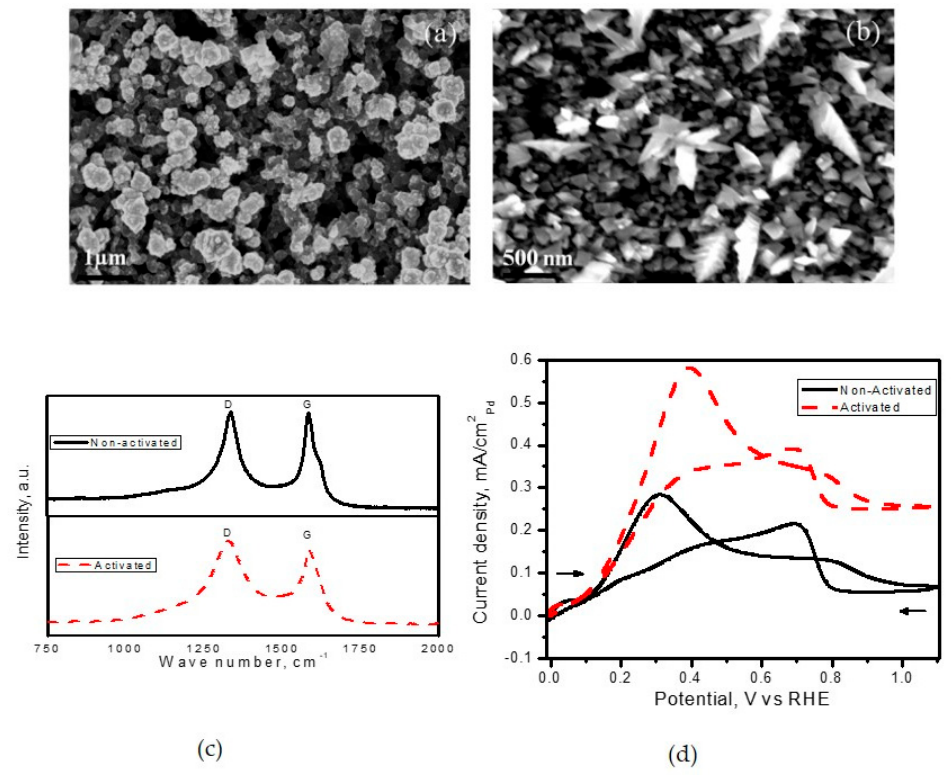
Figure 6. Scanning electron micrographs of Pd on ( a ) non-activated carbon support and ( b ) elec- trochemically activated carbon support. ( c ) Raman spectra of non-activated and electrochemically activated Vulcan coated on graphite electrode. Loading of Vulcan on graphite substrate: 100 µ g cm − 2 . Number of electrochemical activation cycles: 100. ( d ) Cyclic voltammograms comparing the specific activity of Pd catalyst on non-activated carbon and electrochemically activated carbon in nitrogen sat- urated 0.5 M H 2 SO 4 and 1 M HCOOH at a scan rate of 20 mV s − 1 and room temperature. Reprinted with permission from